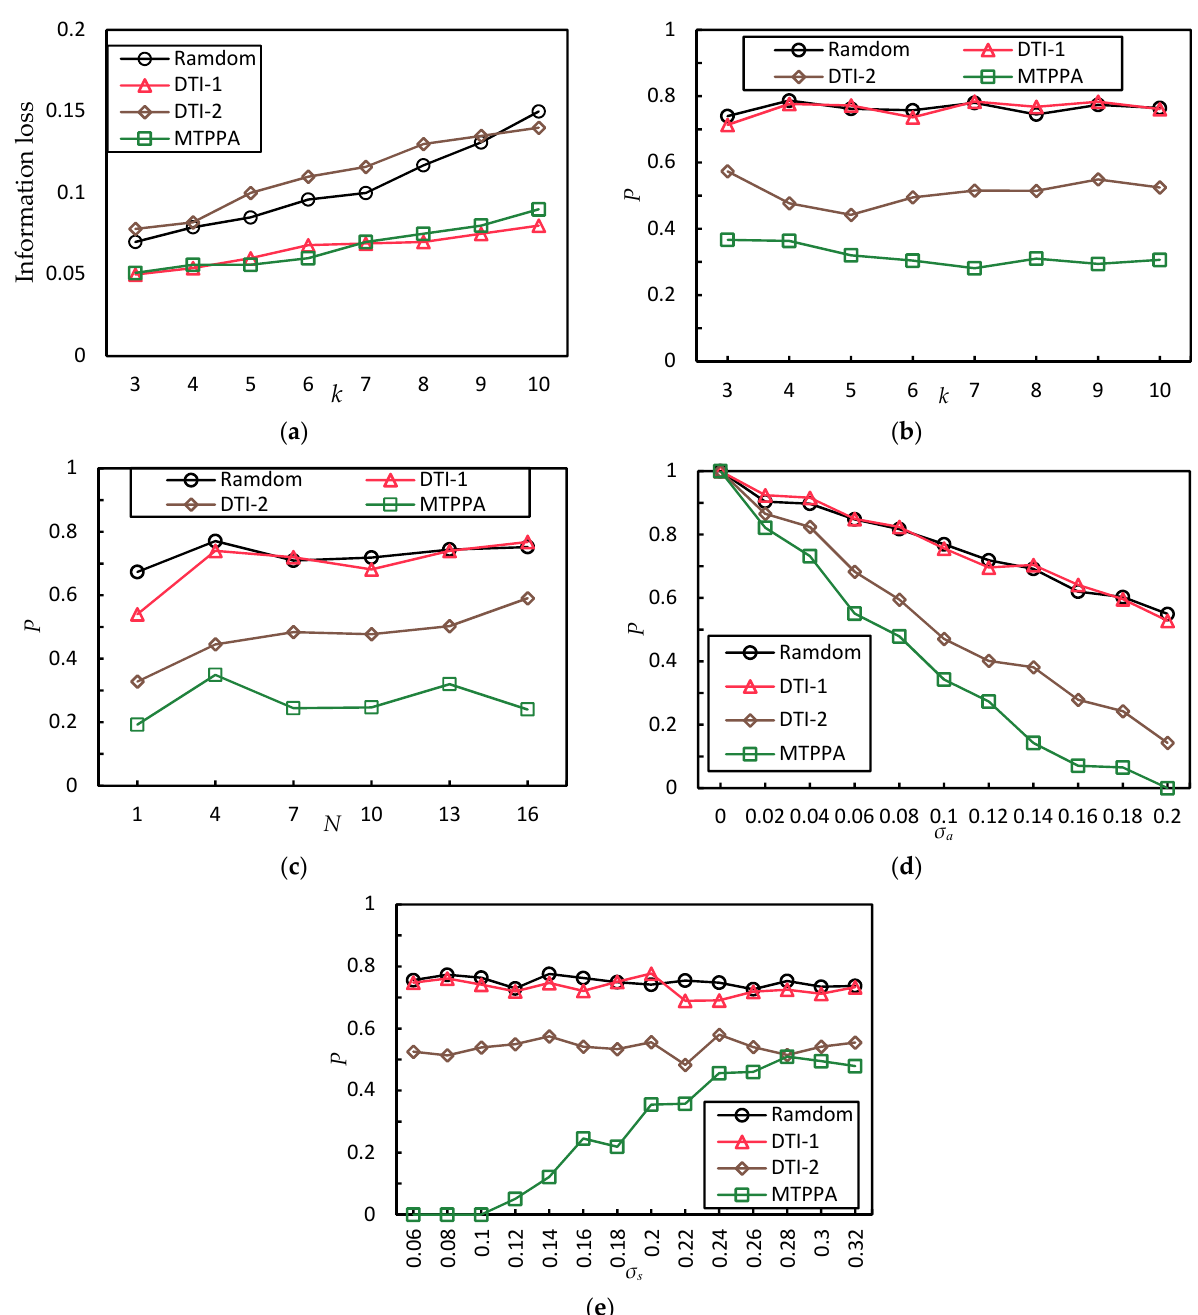
Figure 4. Comparison of algorithms under different parameters. ( a ) Comparison of algorithms in terms of information loss under different k . ( b ) Comparison of algorithms in terms of trajectory privacy disclosure probability under different k . ( c ) Comparison of algorithms in terms of trajectory privacy disclosure probability under different N . ( d ) Comparison of algorithms in terms of trajectory privacy disclosure probability under different σ a . ( e ) Comparison of algorithms in terms of trajectory privacy disclosure probability under different σ s